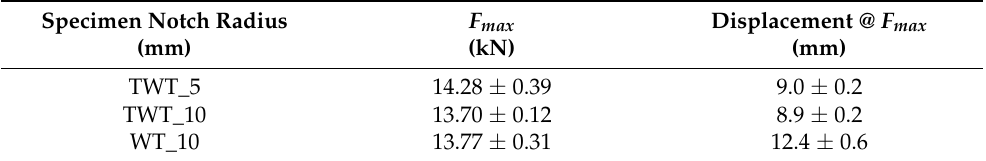
Table 5. Maximum load and corresponding displacement of Type A, 225 SDR 11 TWT, and WT